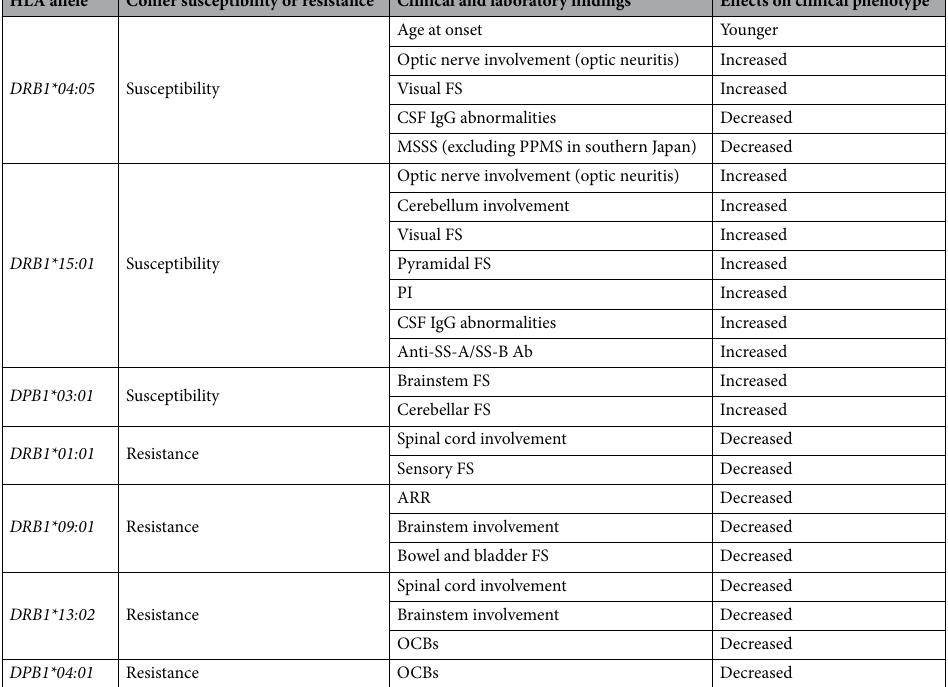
Table 4. Summary of HLA genotype-clinical phenotype correlations in MS. If the effects were derived from only 5 or less than 5 positive cases, such findings were regarded as too preliminary, and therefore they are not described in the table. Ab antibody, CSF cerebrospinal fluid, FS functional system, LESCL longitudinally extensive spinal cord lesion, MS multiple sclerosis, OCBs oligoclonal IgG bands, PI Progression